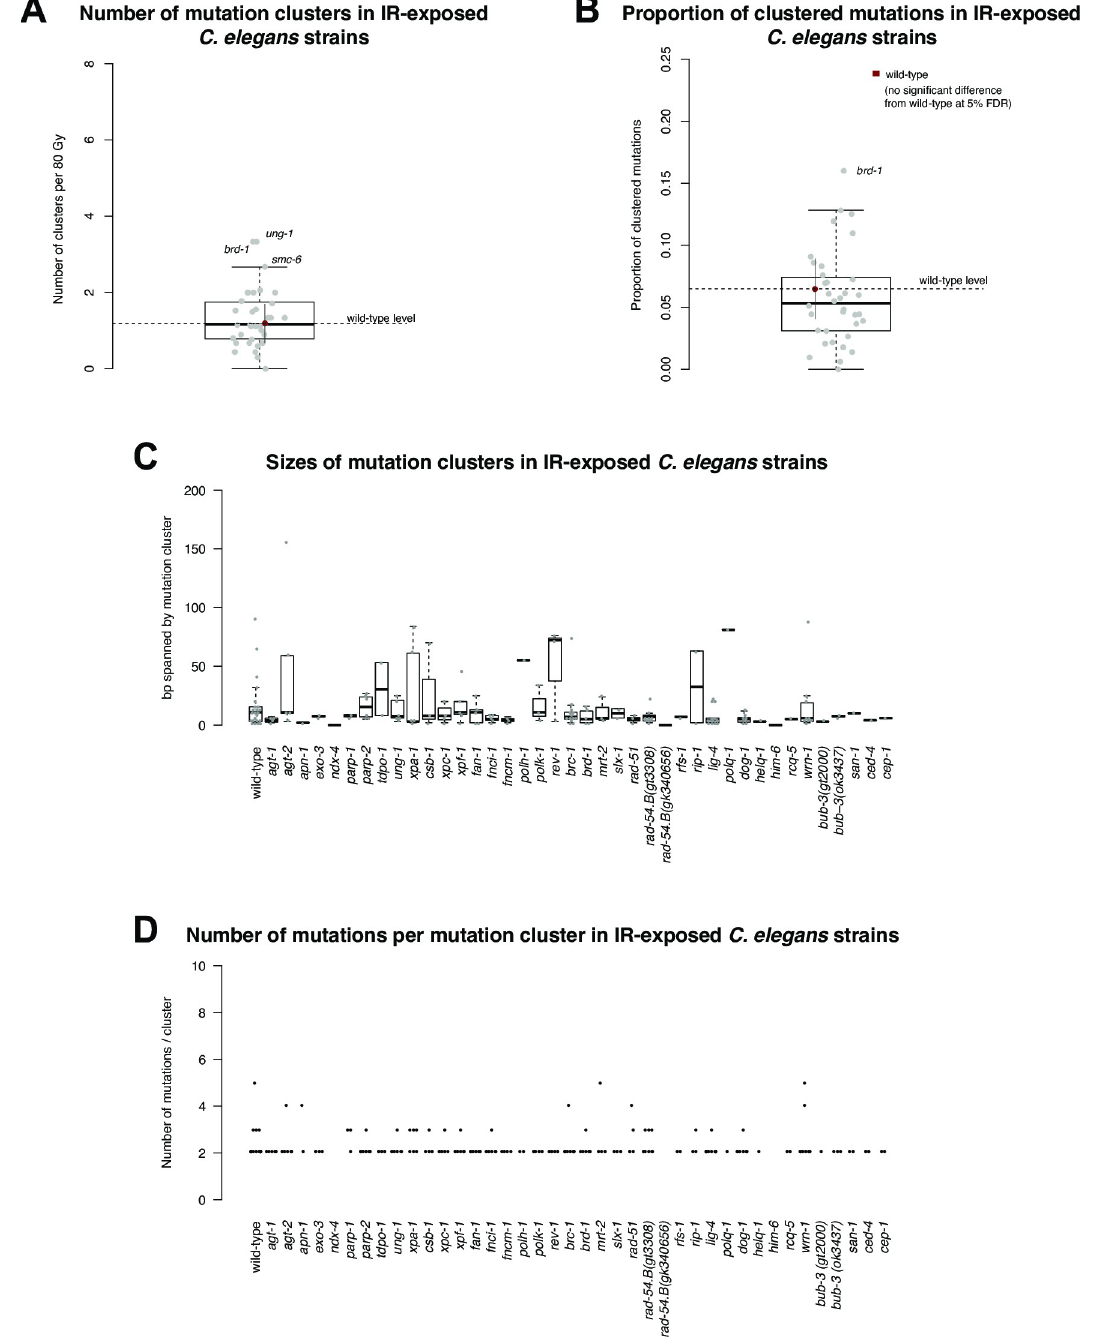
Fig 5. IR-induced mutation clusters. A. Number of mutation clusters in IR-exposed C . elegans strains per 80 Gy of Cs-137 radiation. Grey dots indicate the number of mutation clusters in different C . elegans mutants. The red dot and dashed line indicate the number of mutation clusters observed in wild-type. Black bars indicate the median mutation cluster size, squares the interquartile range and the error bar the low and high 1.5 � interquartile ranges. B. Proportion of IR-induced mutations within clusters for wild-type (red dot, dashed line) and DNA repair deficient C . elegans lines (grey dots) as depicted in A. C. Boxplots representing the sizes of IR-induced mutation clusters in bp for wild-type and DNA repair mutants. Grey dots represent the size of individual mutation clusters observed for the respective genotype. D. Number of mutations per mutation cluster (black dots) in IR-exposed wild-type and DNA repair mutants.